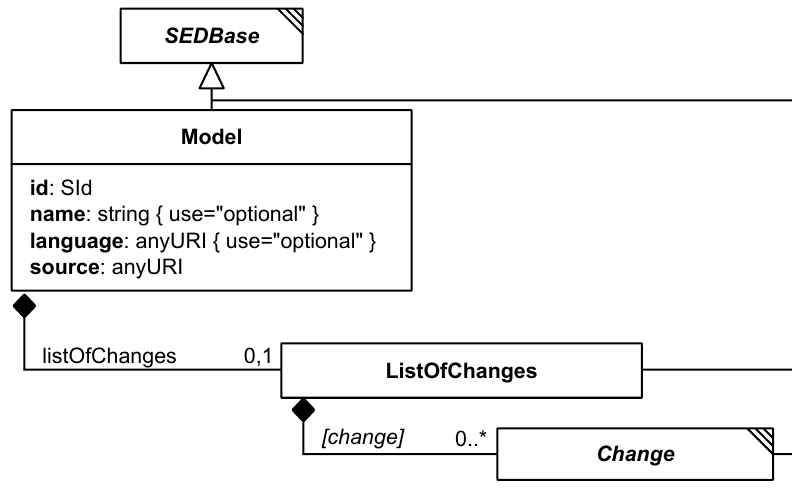
Figure 2.9: The SED-ML Model